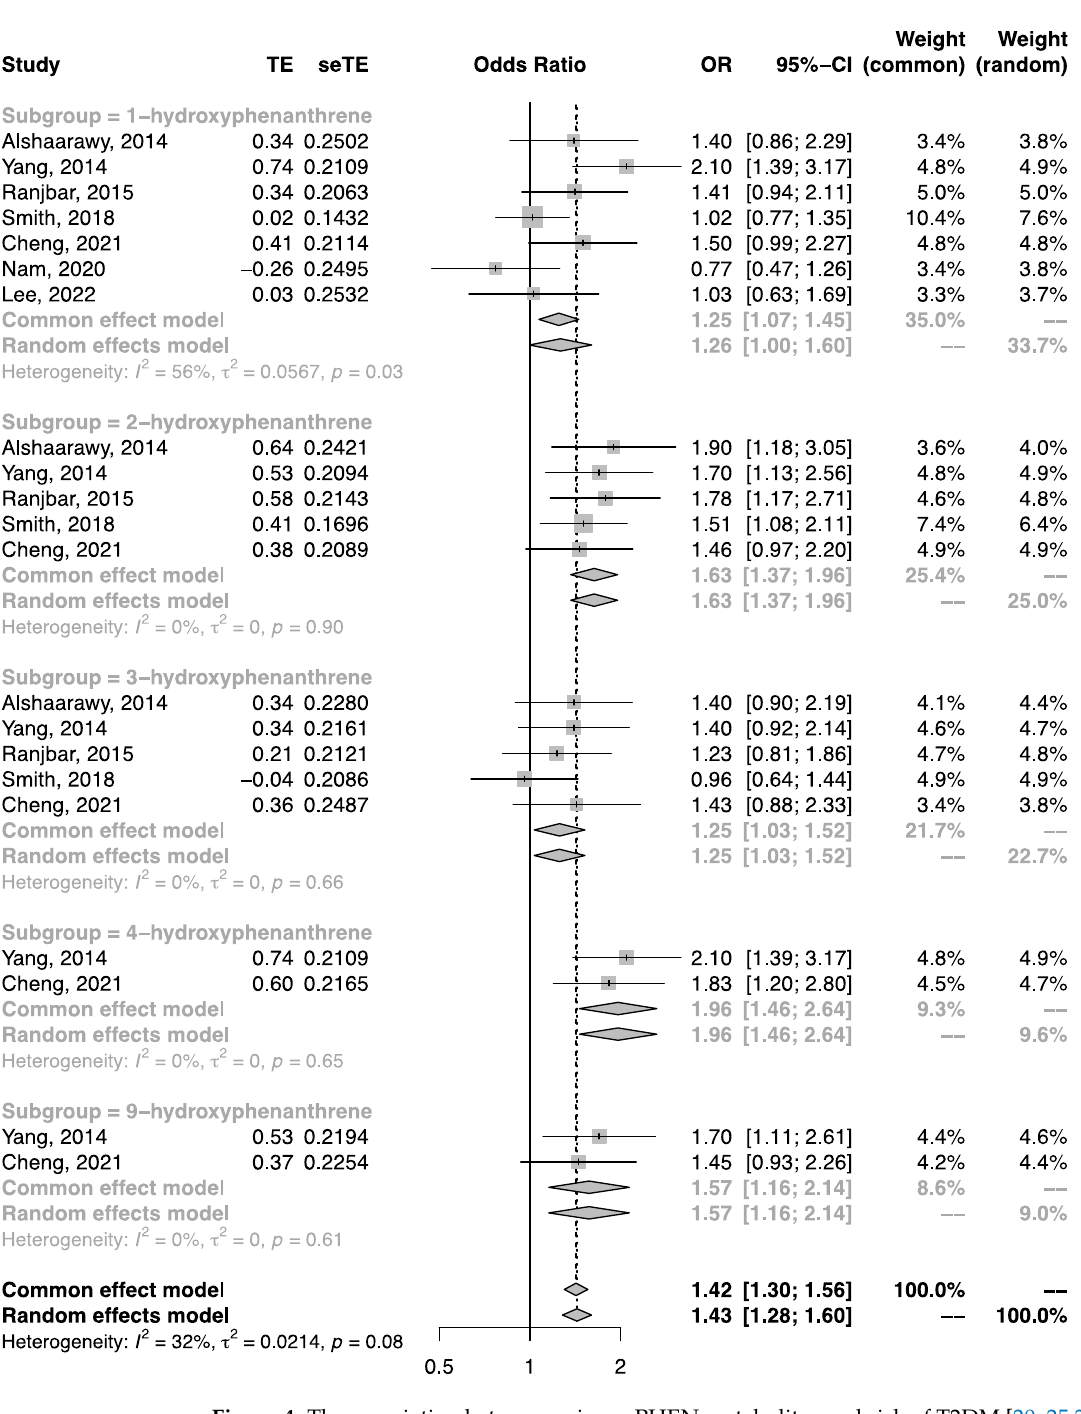
Figure 4. The association between urinary PHEN metabolites and risk of T2DM [20–25,28].